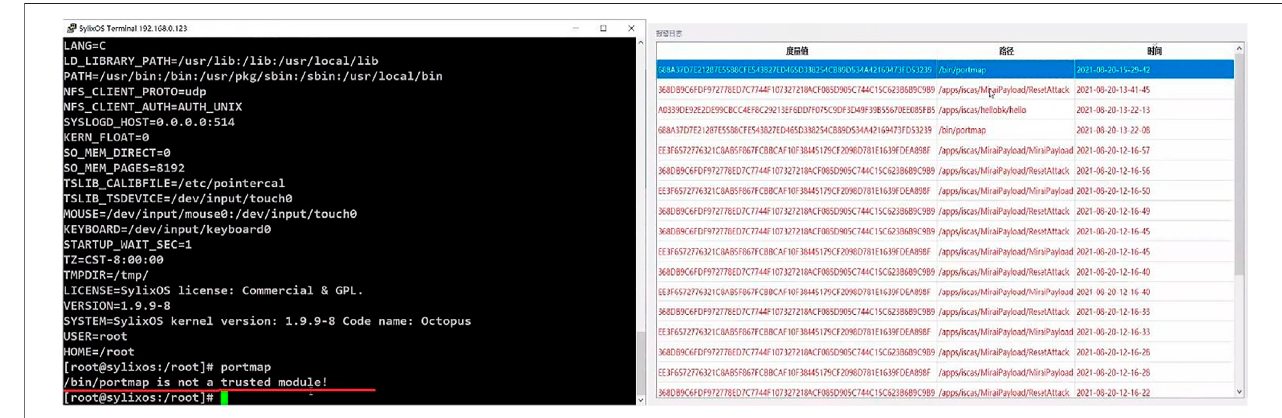
FIGURE 9 | A malicious program “ portmap.cid ” is identi fi ed as an illegal program.